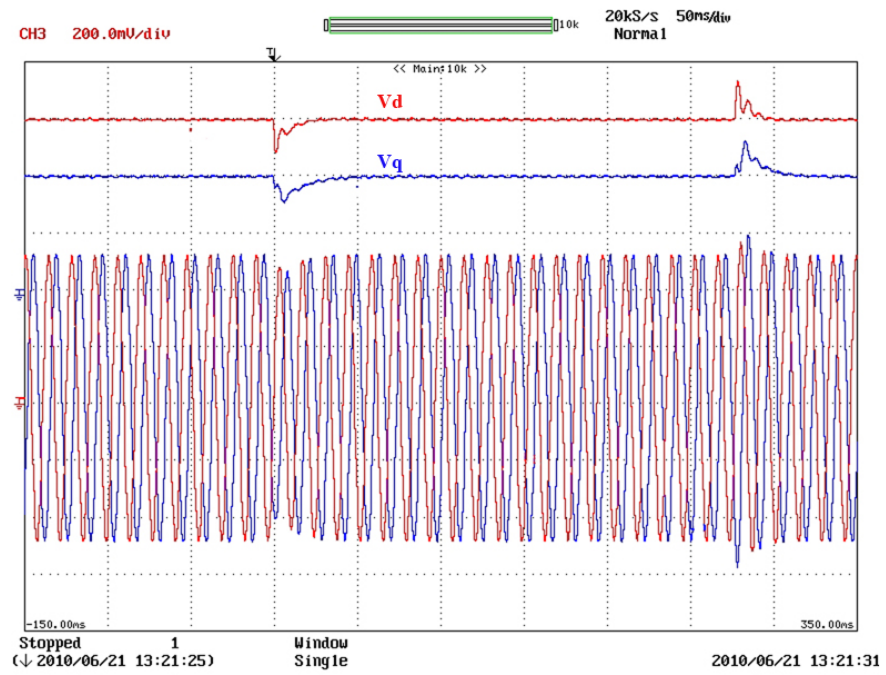
Figure 14. Oscilloscope screen capture of the d and q components of the load voltage, and the phase a and b voltages of the